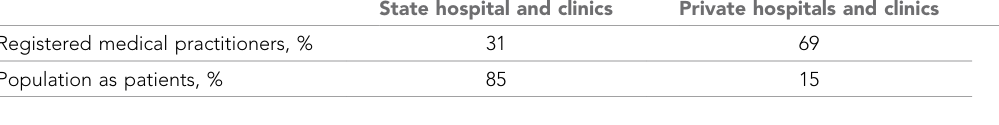
Table 1. Distribution of healthcare workers and patients across private and public sector health care State hospital and clinics